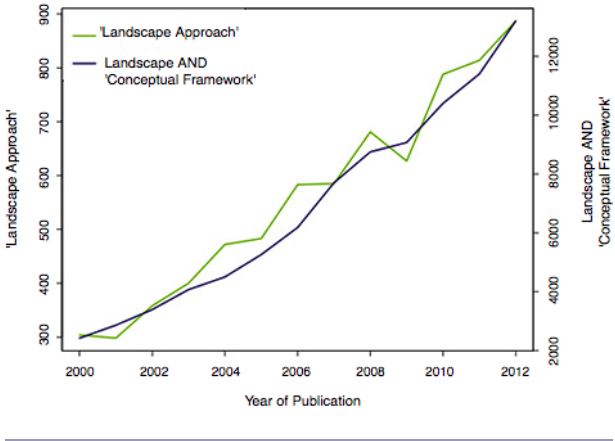
Fig. 1 . Increases in the number of landscape-related publications over the past decade as demonstrated by two sets of search terms and the number of returned hits for each publication year within Google Scholar (searches were conducted on 14 October